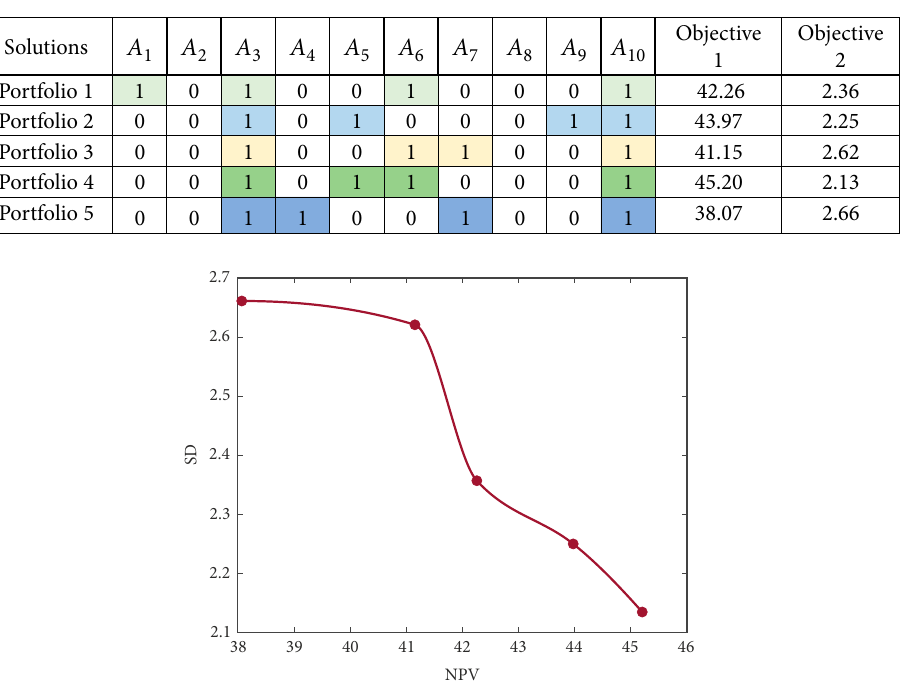
Table 9. Non-dominated solutions of Model 3